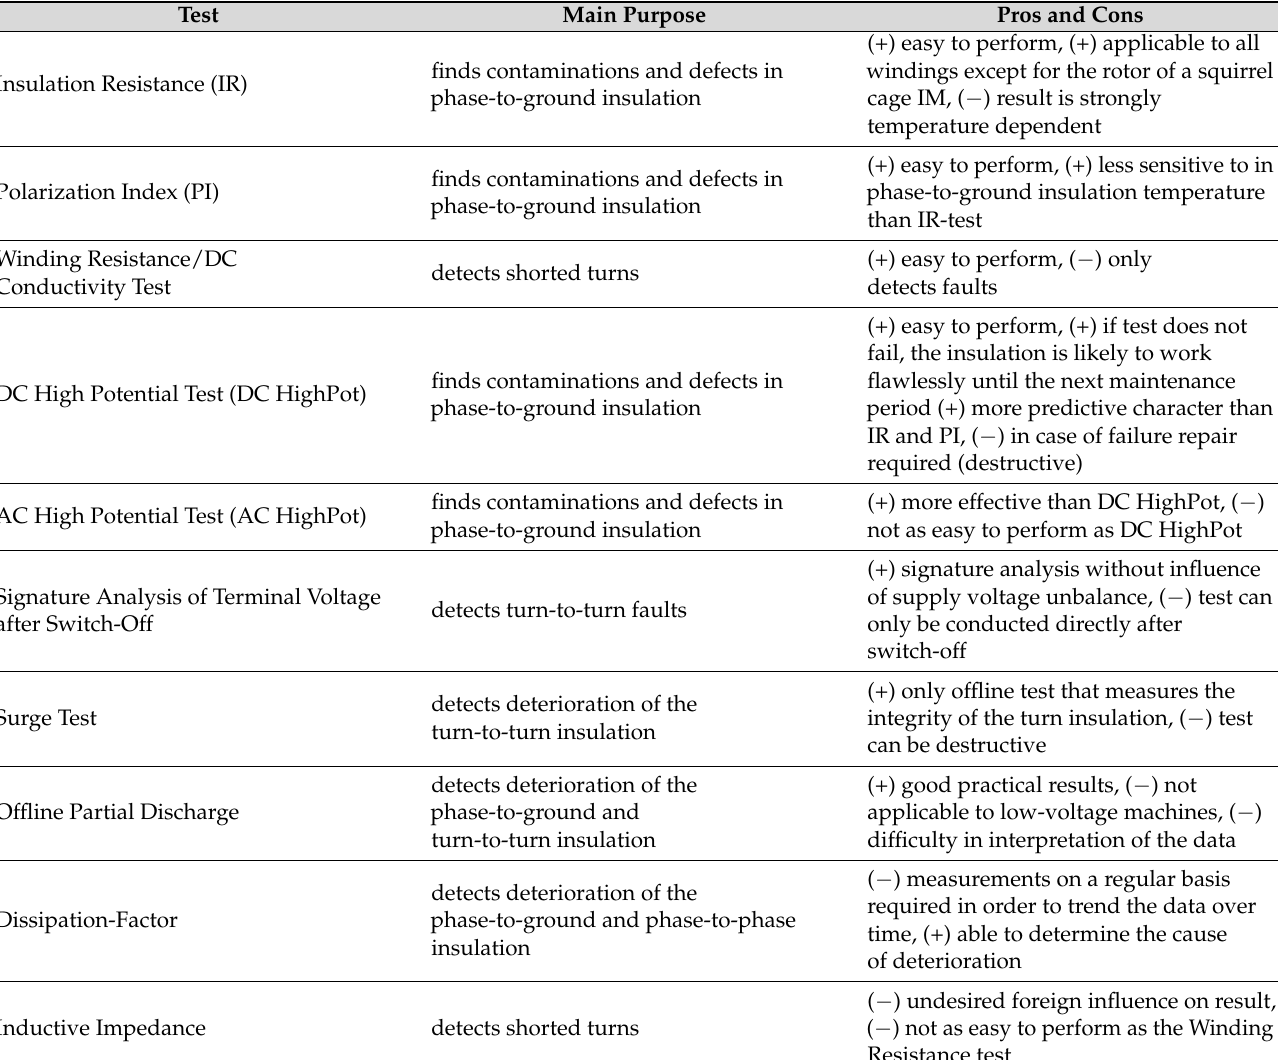
Table 4. Testing Electrical Insulation System using Different Offline Methods